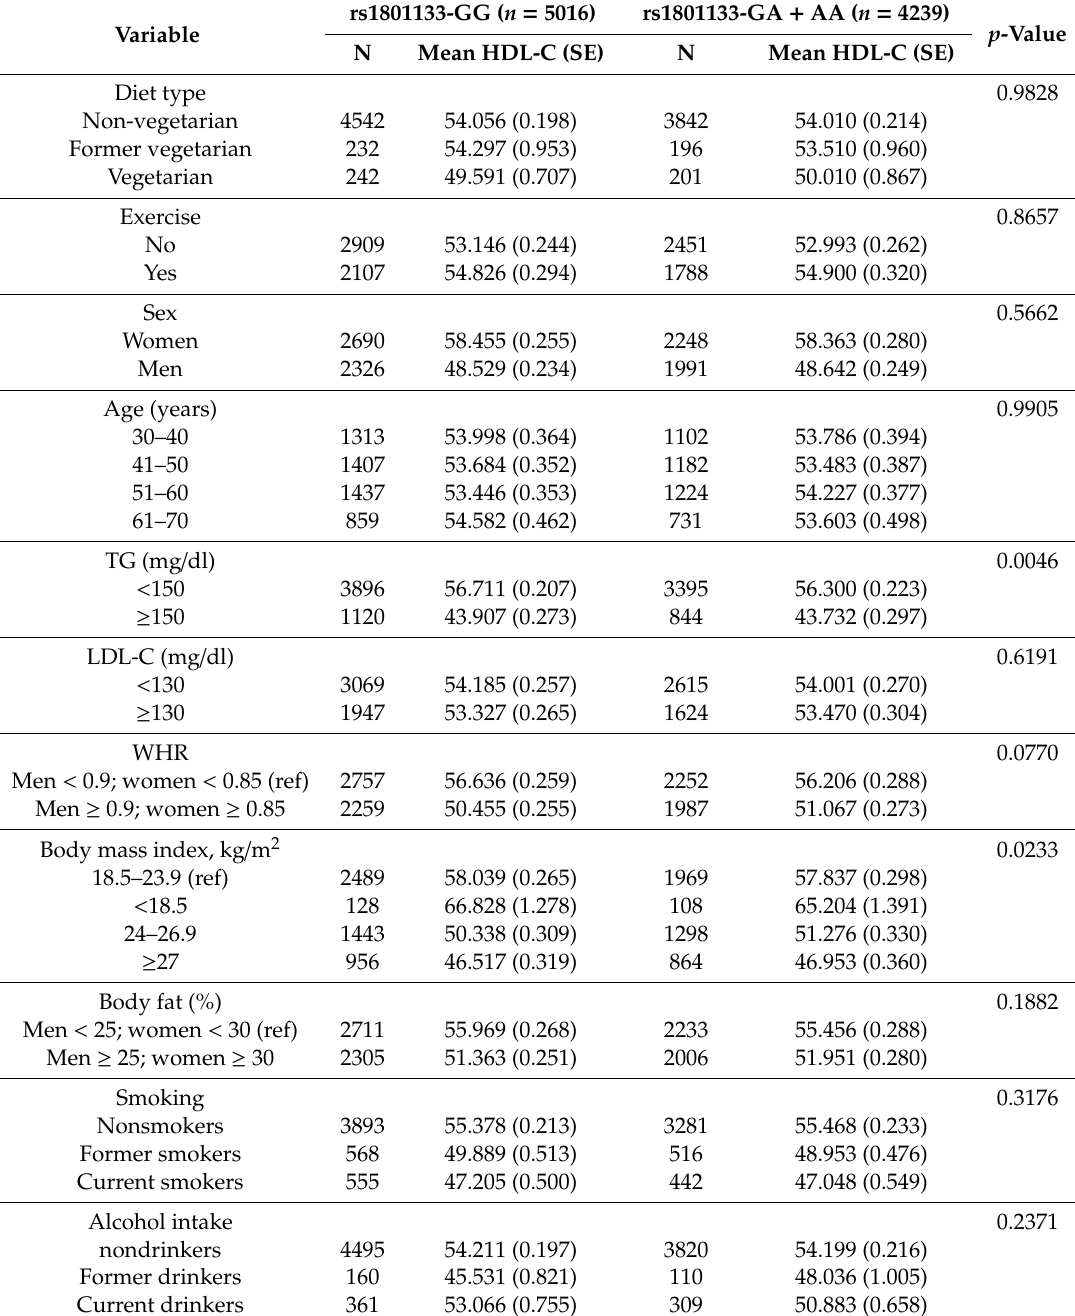
Table 1. Demographic characteristics of participants grouped by rs1801133